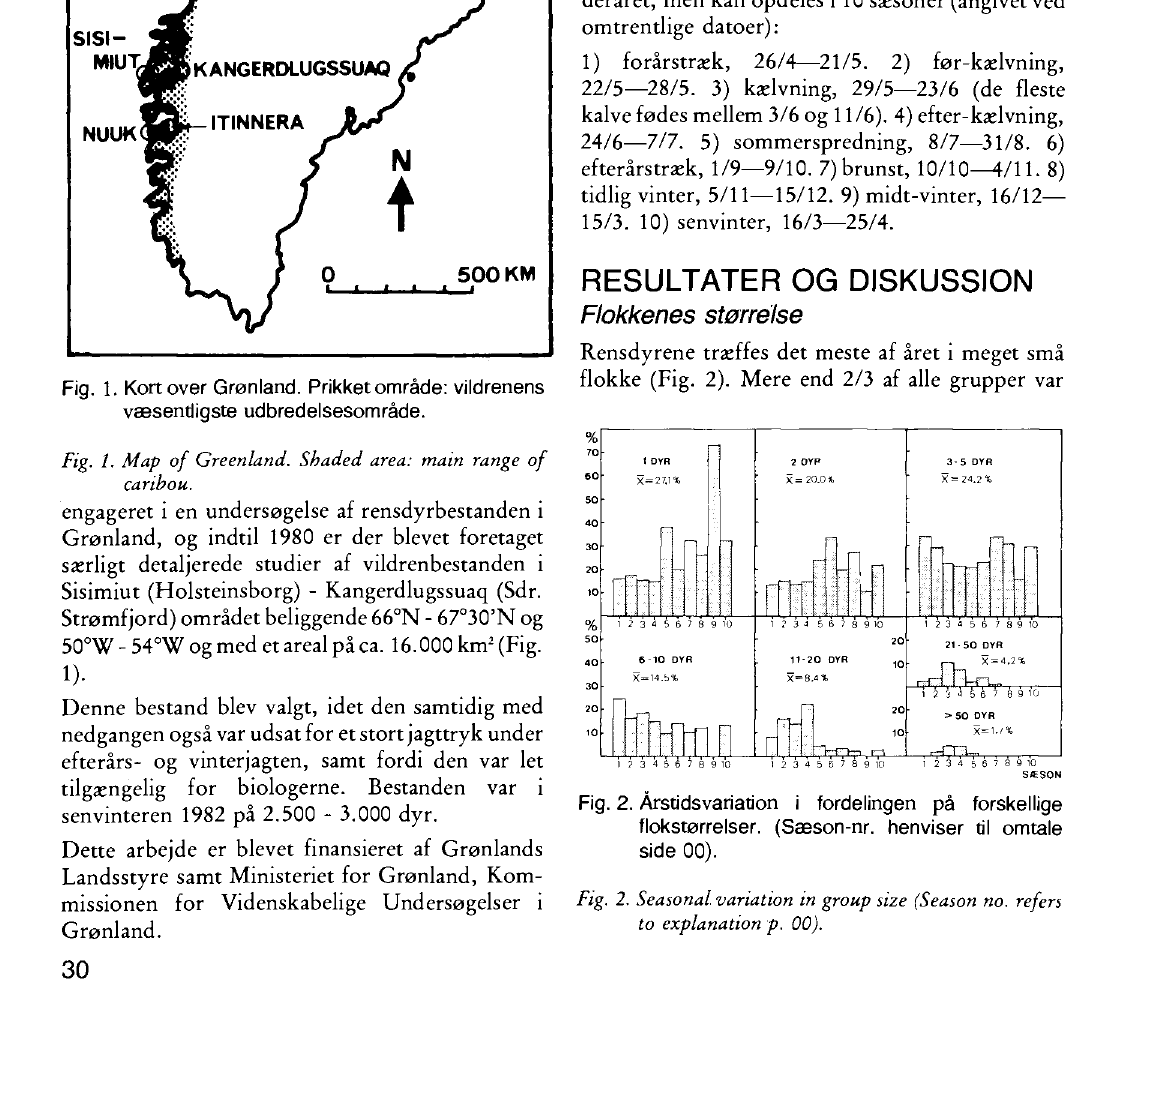
Fig. 2. Årstidsvariation i fordelingen på forskellige flokstørrelser. (Sæson-nr. henviser til omtale side 00). Fig. 2. Seasonal variation in group size (Season no. refers to explanation p.